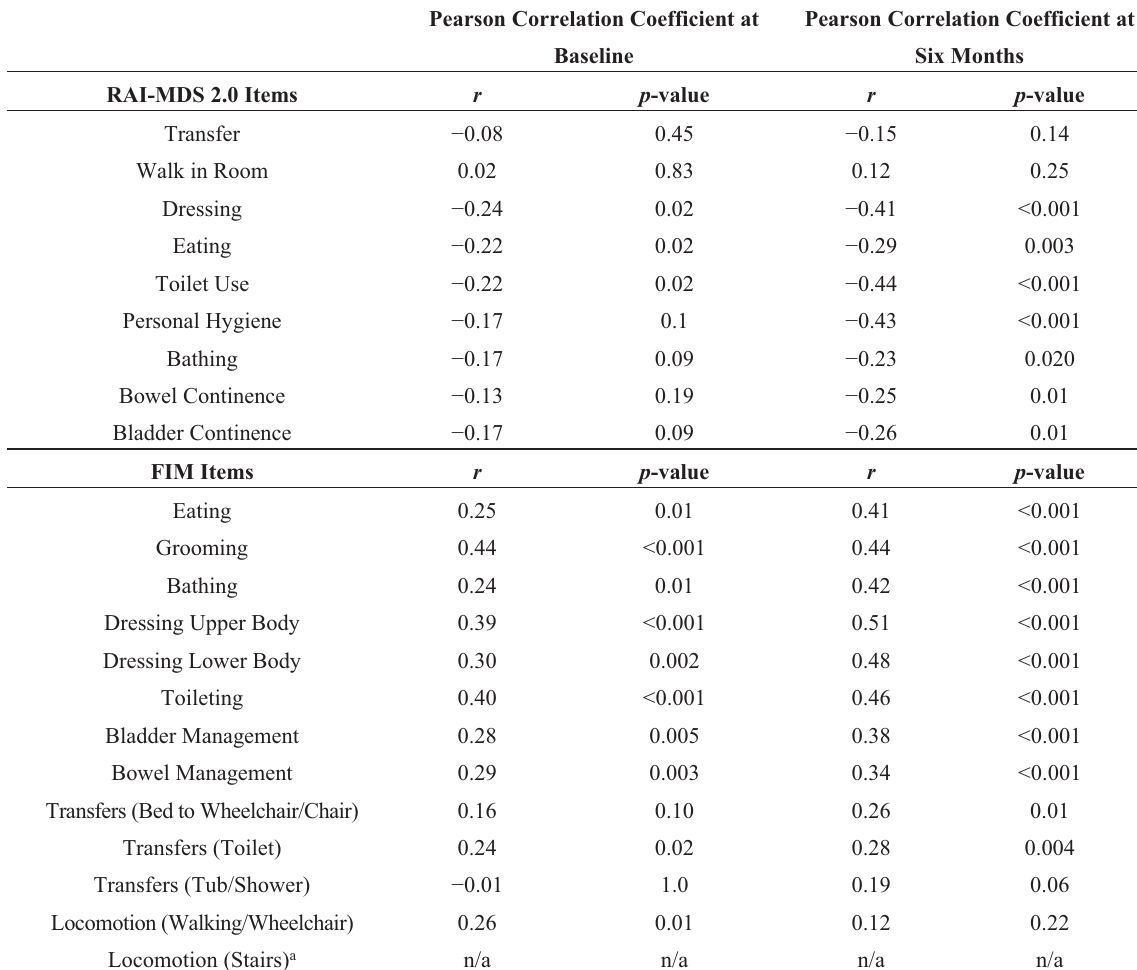
Table 5. Correlation of QOL-AD scores and individual RAI-MDS and FIM item scores. Pearson Correlation Coefficient at Pearson Correlation Coefficient at Baseline Six